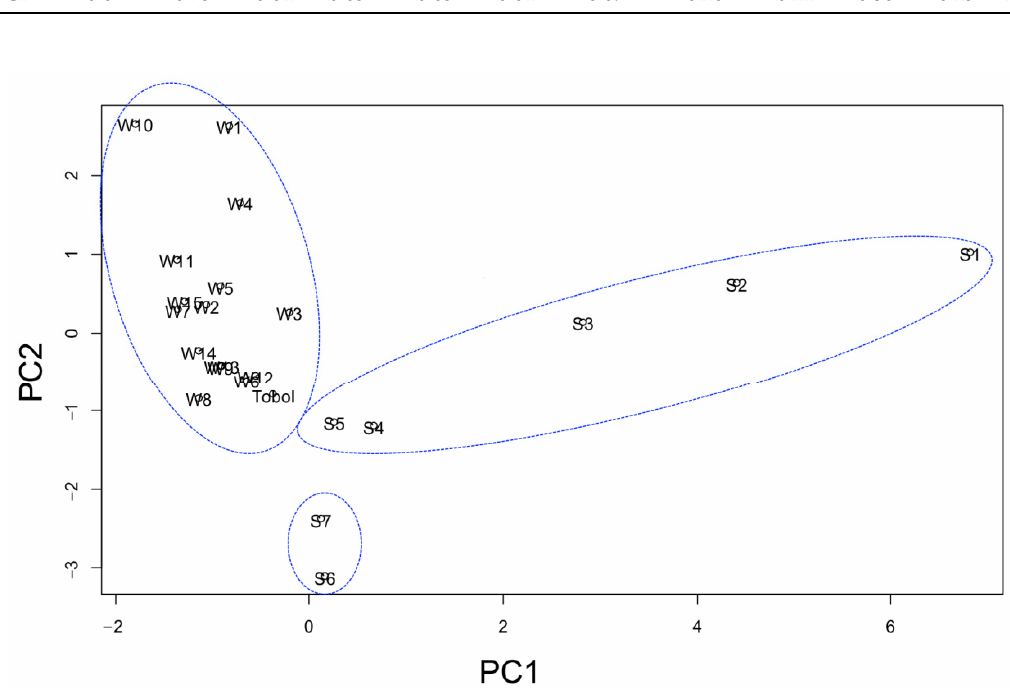
Figure 8. Principle components plot, physico-chemical composition in sampling points.